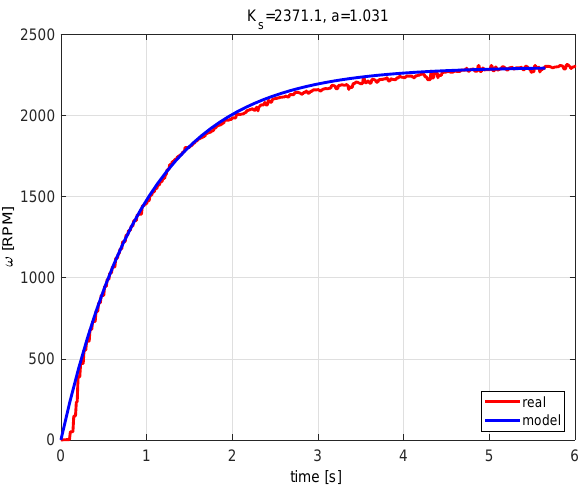
Figure 7. First order model approximation.